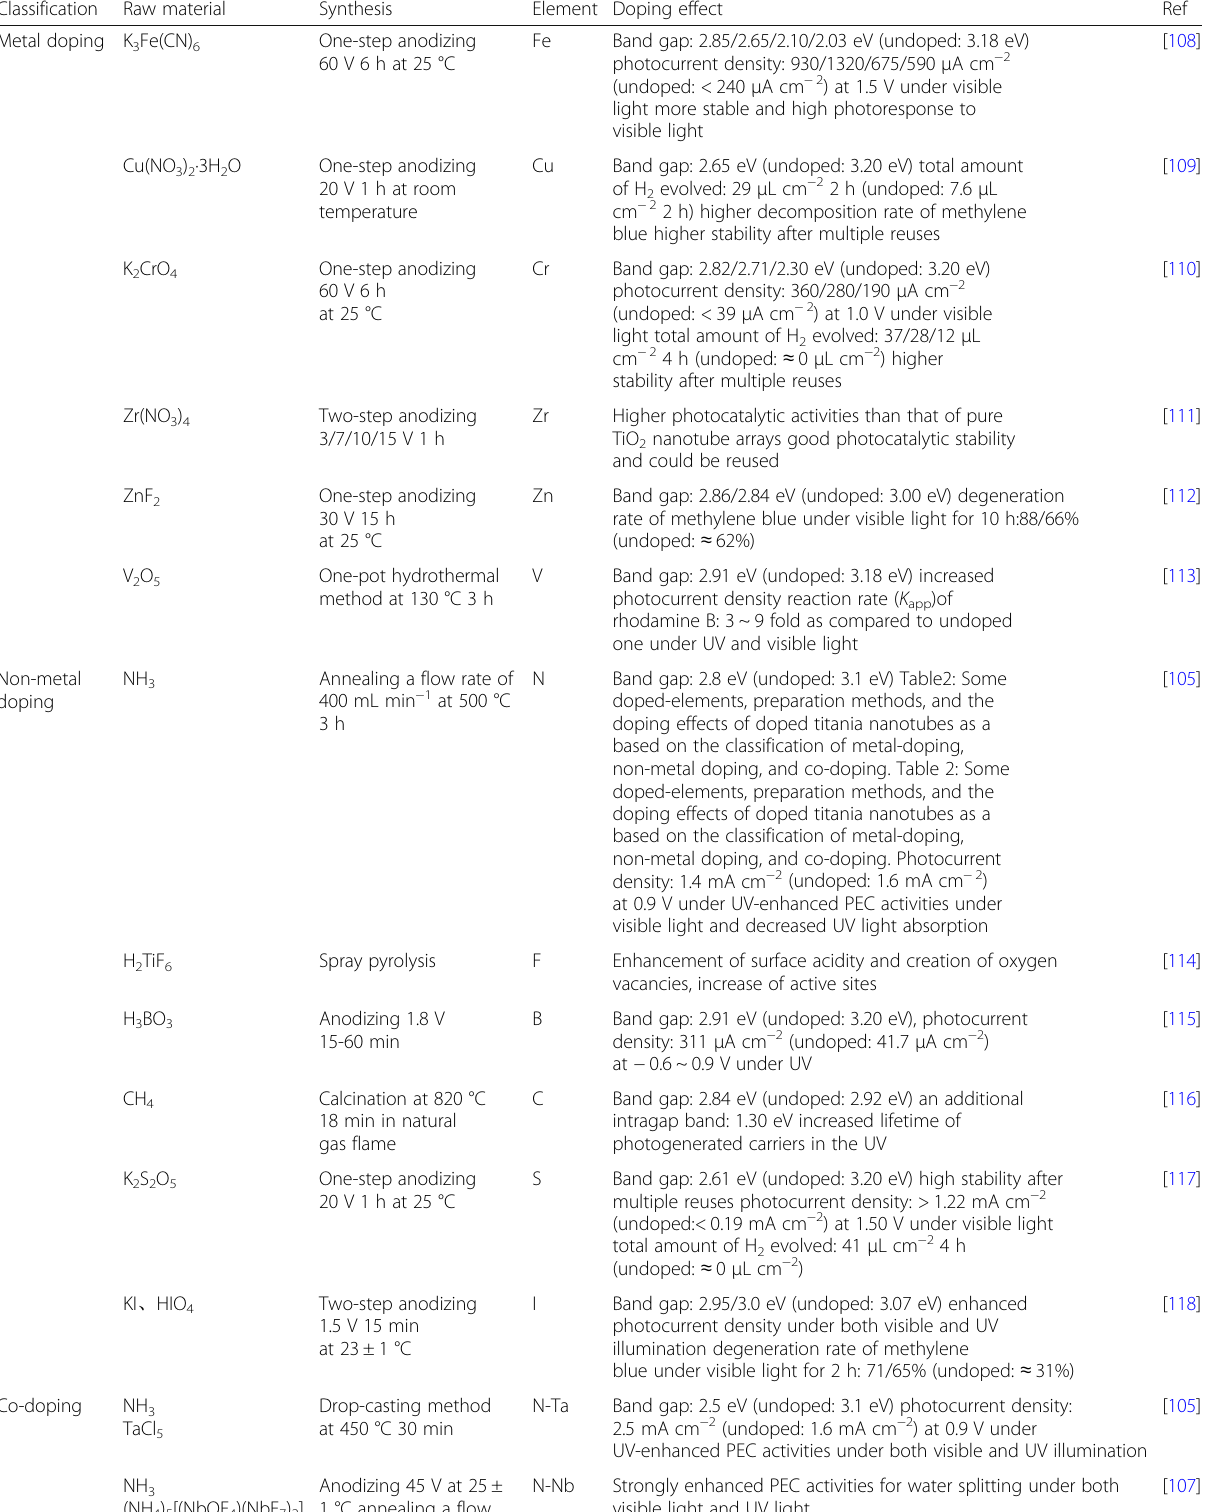
Table 2 Some doped-elements, preparation methods, and the doping effects of doped titania nanotubes as based on the classification of metal-doping, non-metal doping, and